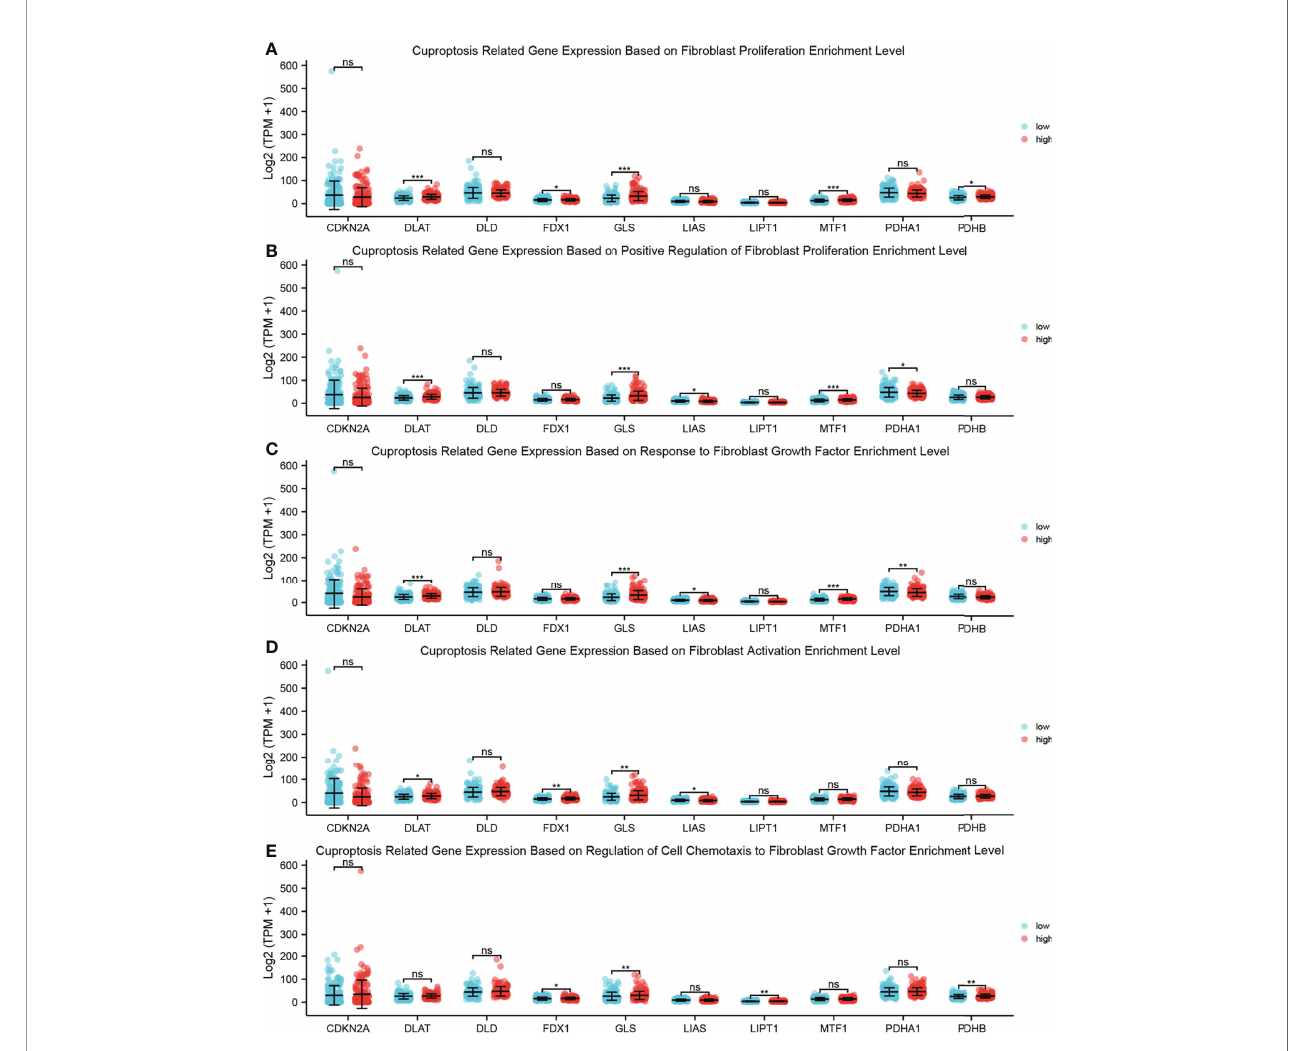
FIGURE 8 | ssGSEA between cuproptosis-related gene expression and fi broproliferation-related biological processes. (A) Dot plot shows the relationship between cuproptosis-related gene expression and fi broblast proliferation enrichment level; a rank-sum test was used to analyze the data (n = 328, *p < 0.05; ***p < 0.001; ns, not signi fi cant). (B) Dot plot shows the relationship between cuproptosis-related gene expression and positive regulation of fi broblast proliferation enrichment level; a rank-sum test was used to analyze the data (n = 328, *p < 0.05; ***p < 0.001; ns, not signi fi cant). (C) Dot plot shows the relationship between cuproptosis-related gene expression and response to fi broblast growth factor enrichment level; a rank-sum test was used to analyze the data (n = 328, *p < 0.05; **p < 0.01; ***p < 0.001; ns, not signi fi cant). (D) Dot plot shows the relationship between cuproptosis-related gene expression and fi broblast activation enrichment level; a rank-sum test was used to analyze the data (n = 328, *p < 0.05; **p < 0.01; ns, not signi fi cant). (E) Dot plot shows the relationship between cuproptosis-related gene expression and regulation of cell chemotaxis to fi broblast growth factor enrichment level; a rank-sum test was used to analyze the data (n = 328, *p < 0.05; **p < 0.01; ns, not signi fi cant). ssGSEA, single-sample Gene Set Enrichment